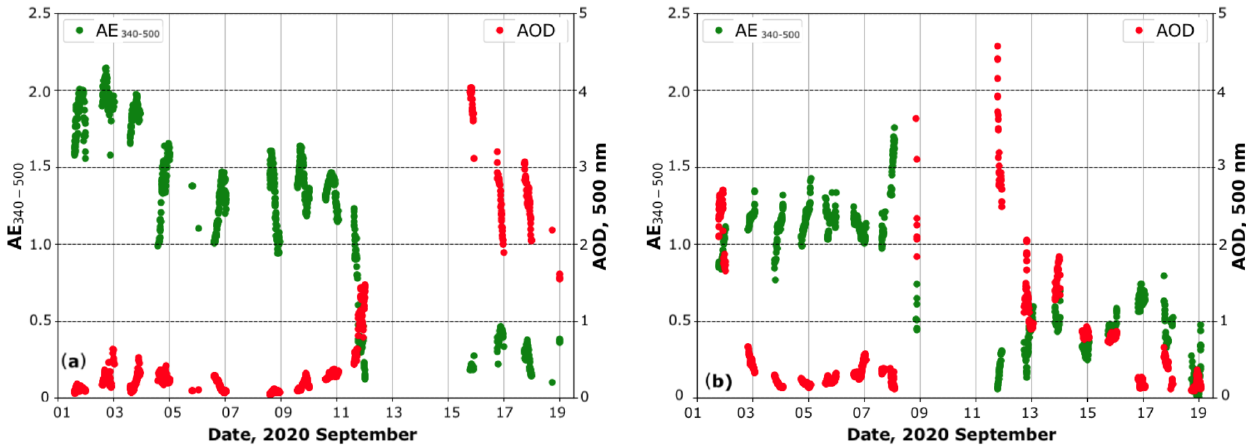
Figure 3. AOD and AE (Level 1.5) measured by AERONET sun/photometers at two observation sites: (a) PNNL (46 ◦ N, 119 ◦ W) and (b) NASA_Ames (37.420 ◦ N, 122 ◦ W). NASA_Ames is within the influence of both the Creek fire and the Oregon fire. PNNL is mainly impacted by the smoke of the Oregon fire. The smoke of the Oregon fire arrived at NASA_Ames on about 9 September and at PNNL on 12 September 2020. The arrival of the Oregon smoke caused significant increase in AOD and decease in the AE at both sites.